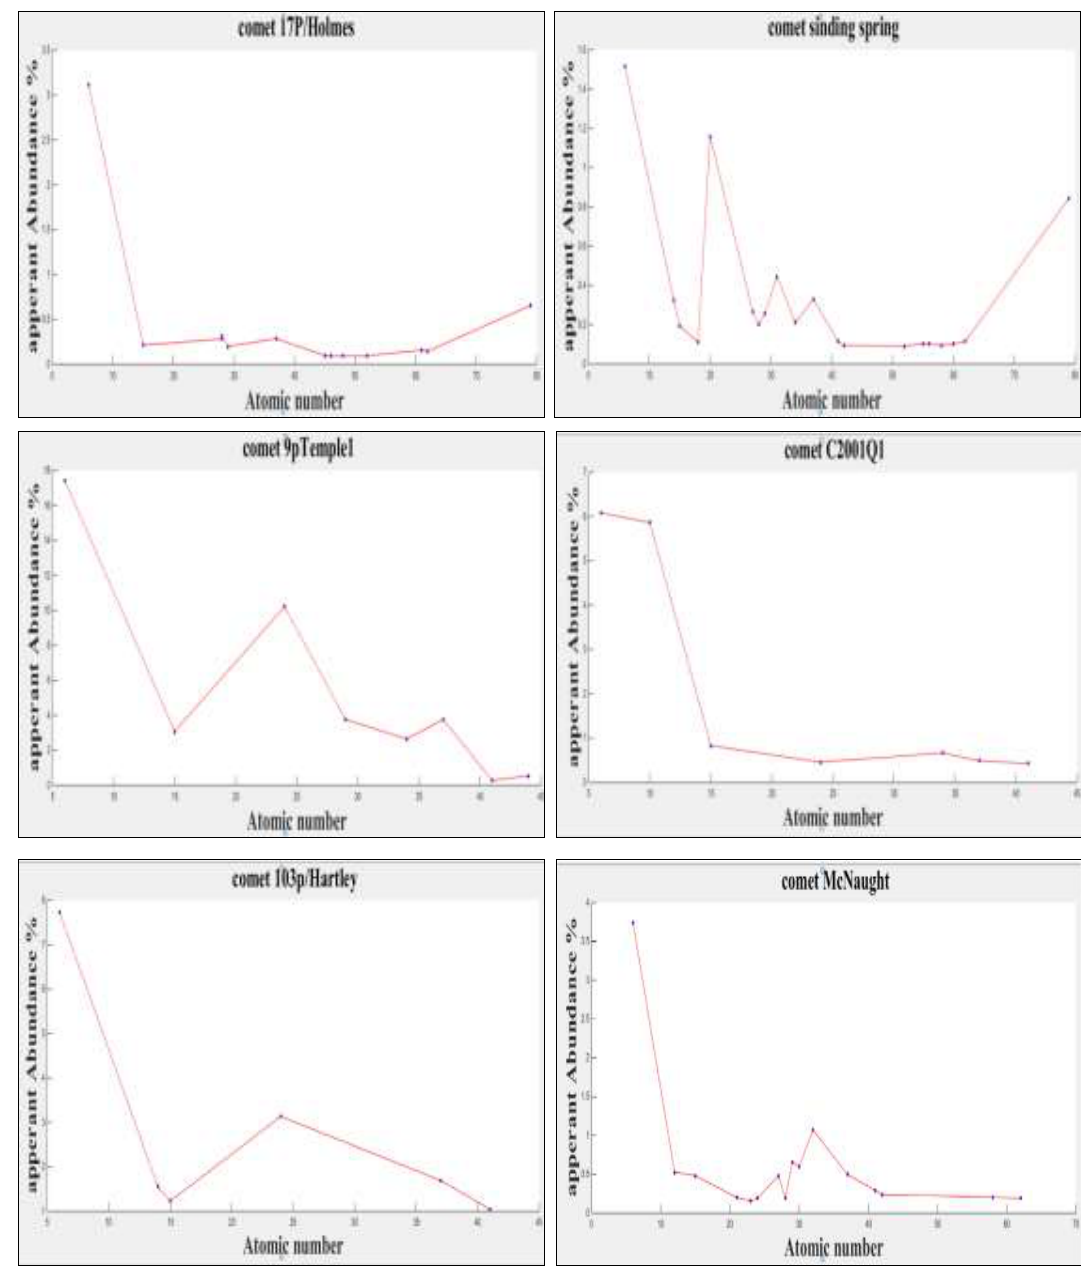
Figure 2: Six comets' apparent abundance by atomic